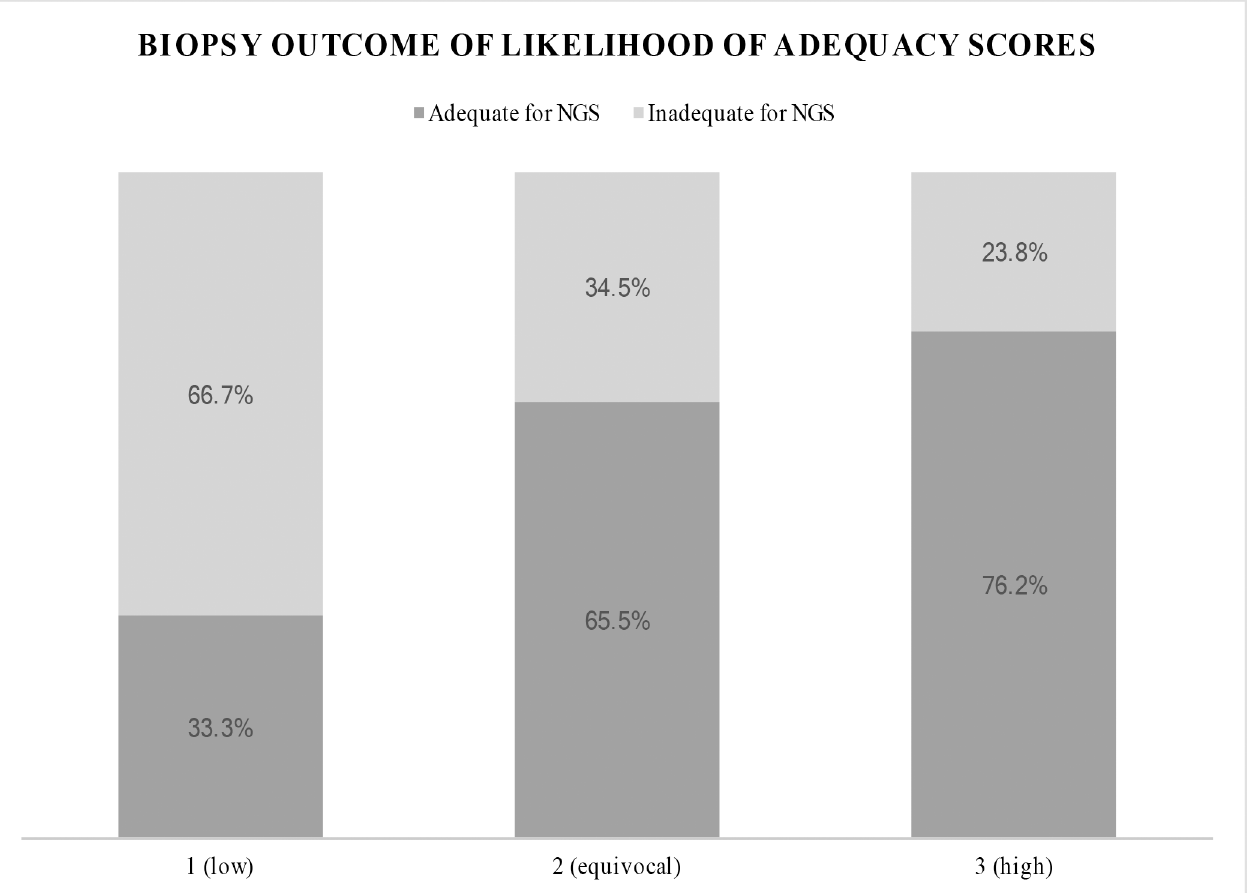
Fig 5. Biopsy outcome of likelihood of adequacy scores. Footnote: NGS: Next Generation Sequencing.